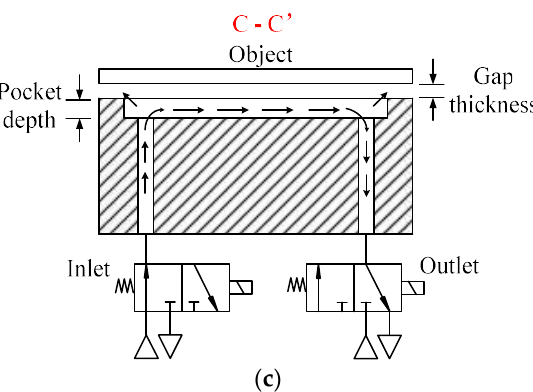
Figure 1. Air conveyor. ( a ) Photograph of the air conveyor. ( b ) A representative unit consisting of 25 actuating cells. ( c ) Cutaway view that shows the working principle.